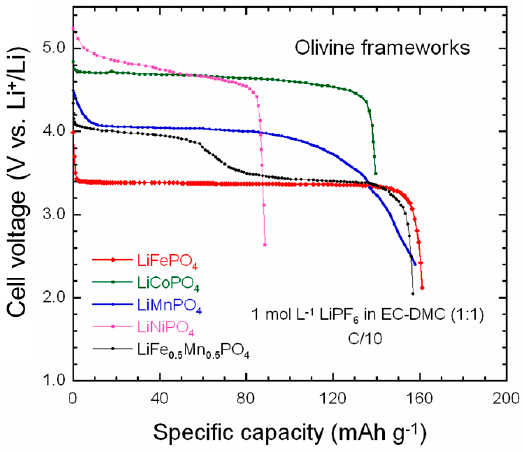
Figure 1. Discharge profiles of Li M PO 4 ( M = Fe, Mn, Ni, Co) olivines and LiFe 0.5 Mn 0.5 PO 4 solid solution as cathodes of Li-ion batteries. Voltages were measured in half cells versus lithium metal.